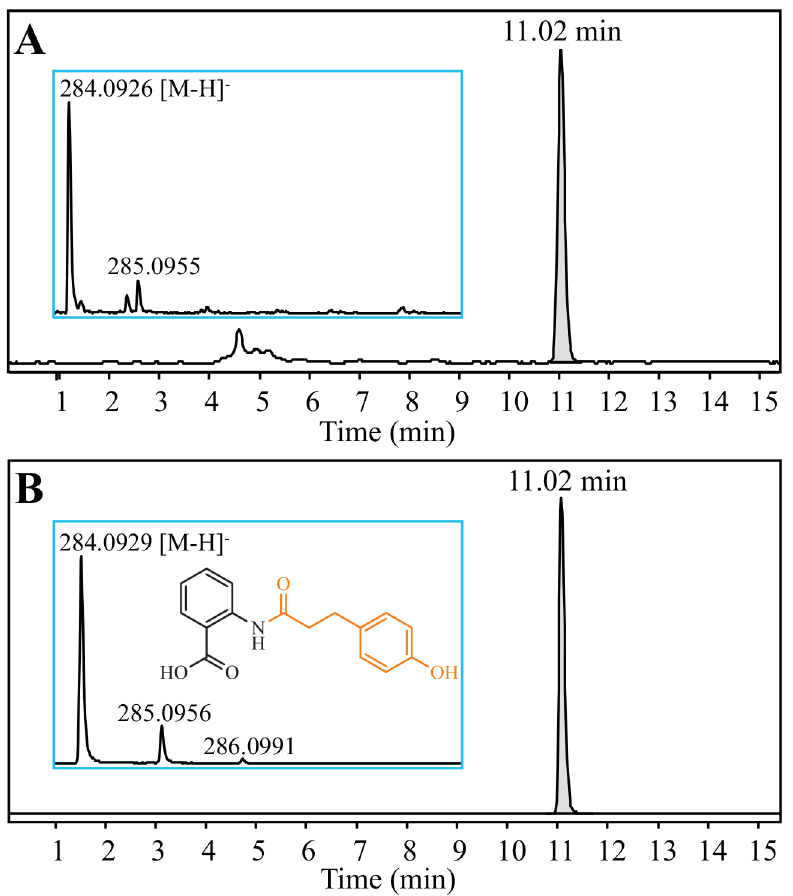
Fig 3. Detection of N -(4 ’ -hydroxydihydrocinnamoyl)-anthranilate (DHavnD) from the recombinant yeast culture medium. Representative ESI-MS spectra were obtained after LC-TOF MS analysis of (A) the culture medium of recombinant yeast incubated with anthranilate and 4-hydroxydihydrocinnamate, and (B) a DHavnD standard